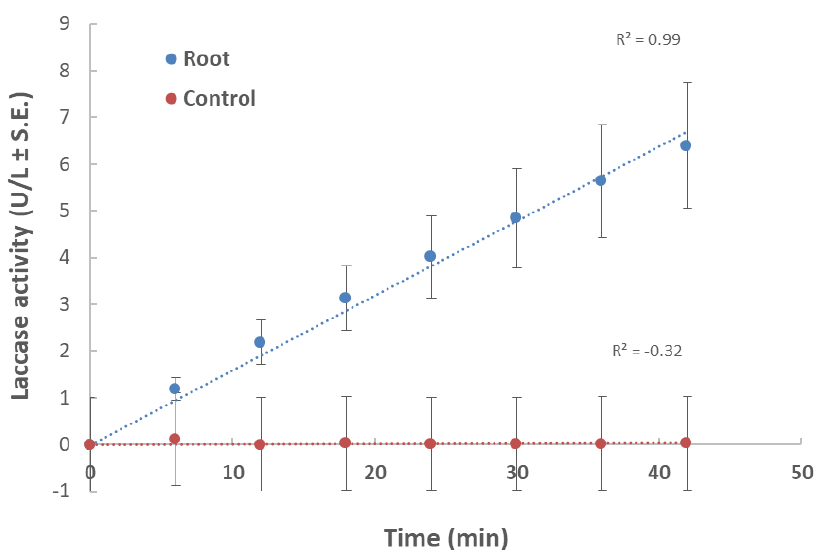
Figure 1. Effect of maize root powder on M. maydis extracellular laccase activity over time: The fungus was grown for seven days in 50 mL of a minimal medium (MM) with 0.1% glucose to which 750 mg of shredded plant parts in liquid nitrogen from 40-day-old Prelude cv. maize plant was added. The control is MM with M. maydis , without root powder. To the growth medium of each treatment and the control (after purification), 2,2′-azinobis (3-ethylbenzothiazoline-6-sulfonic acid) (ABTS) was added. The enzymatic units (U) were defined as the amount of enzyme oxidizing 1 µmol ABTS in 1 min at 28 ± 1 °C in the dark. The values shown are an average of five repetitions.